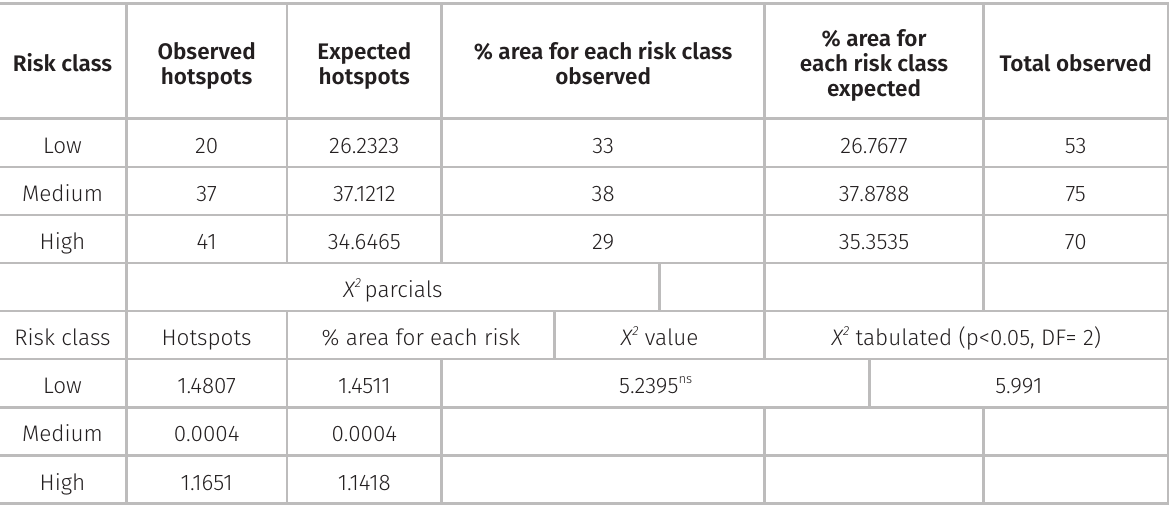
Table IV. Observed and expected frequencies in the number of hotspots and the percentage of area corresponding to each fire risk class by the X 2